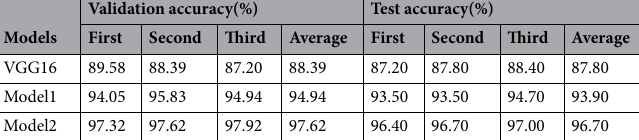
Table 4. Accuracy of the three kinds of network.